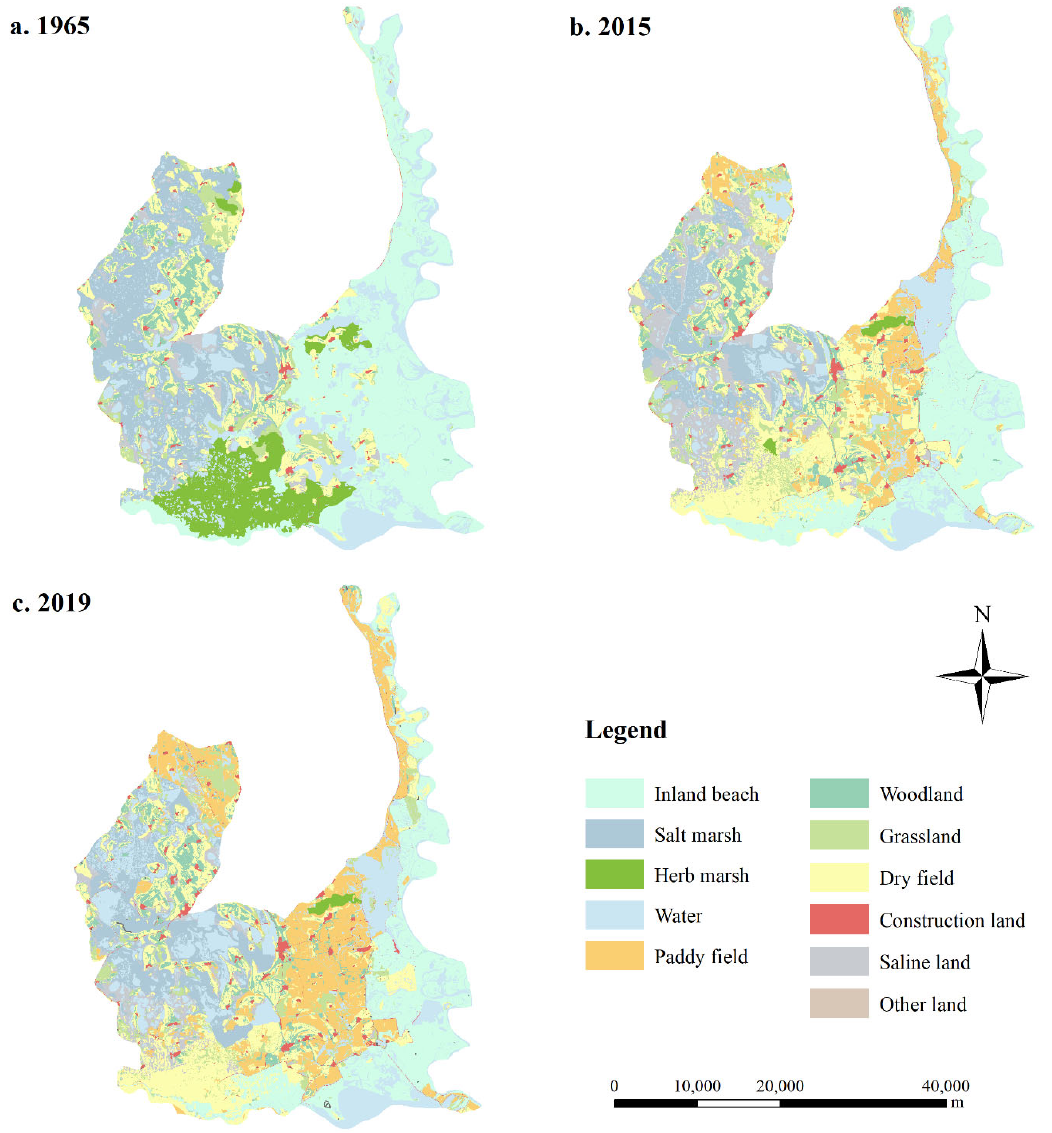
Figure 4. Map of land use types in the Momoge Internationally Important